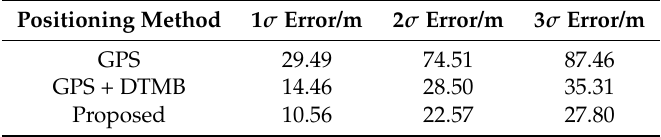
Figure 15. RPE of the three methods at each test point at Site 1: ( a ) RPE in x axis direction of the ECEF system; ( b ) RPE in y axis direction of the ECEF system; and ( c ) RPE in z axis direction of the ECEF system. Table 3. Errors of different positioning methods at Site